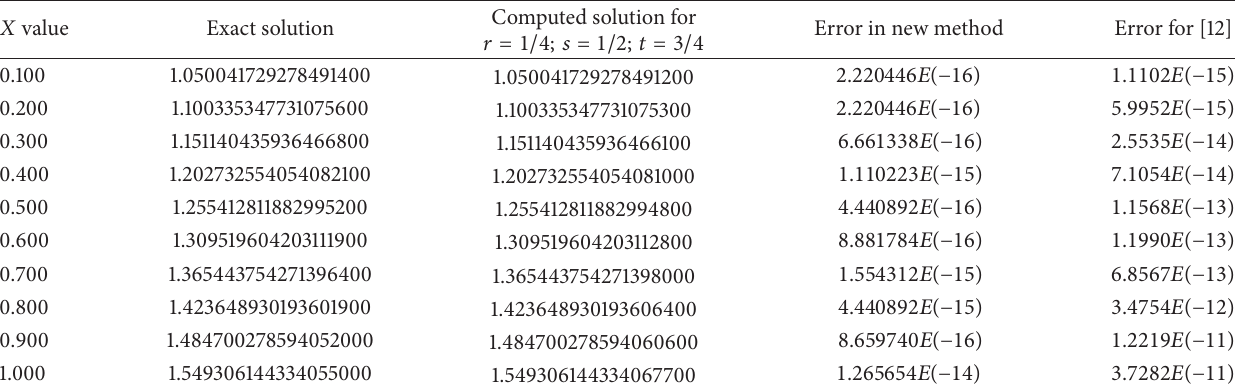
Table 2: Comparison of the proposed method with